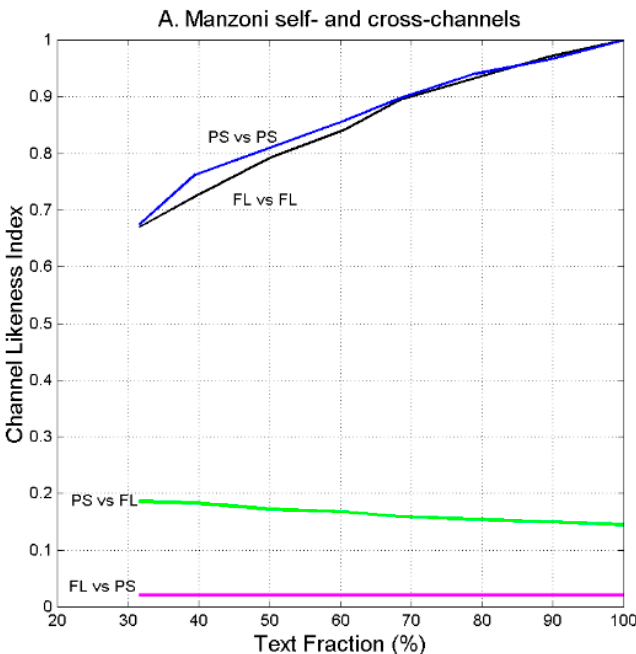
Figure 19. I L vs. text fraction in Alessandro Manzoni’s novels. FL = Fermo e Lucia ; PS = I Promessi Figure 19. 𝐼 (cid:3013) vs. text fraction in Alessandro Manzoni’s novels. FL= Fermo e Lucia ; PS= I Promessi Sposi . Sposi . In the cross-channel Ps vs. FL (green line) g 1 ( y ) refers to Fermo e Lucia . In the cross-channel In the cross ‐ channel Ps vs. FL (green line) 𝑔 (cid:2869) (cid:4666)𝑦(cid:4667) refers to Fermo e Lucia . In the cross ‐ channel FL vs. FL vs. PS (magenta line) g 1 ( y ) refers to I Promessi Sposi PS (magenta line) 𝑔 (cid:2869) (cid:4666)𝑦(cid:4667) refers to I Promessi Sposi.